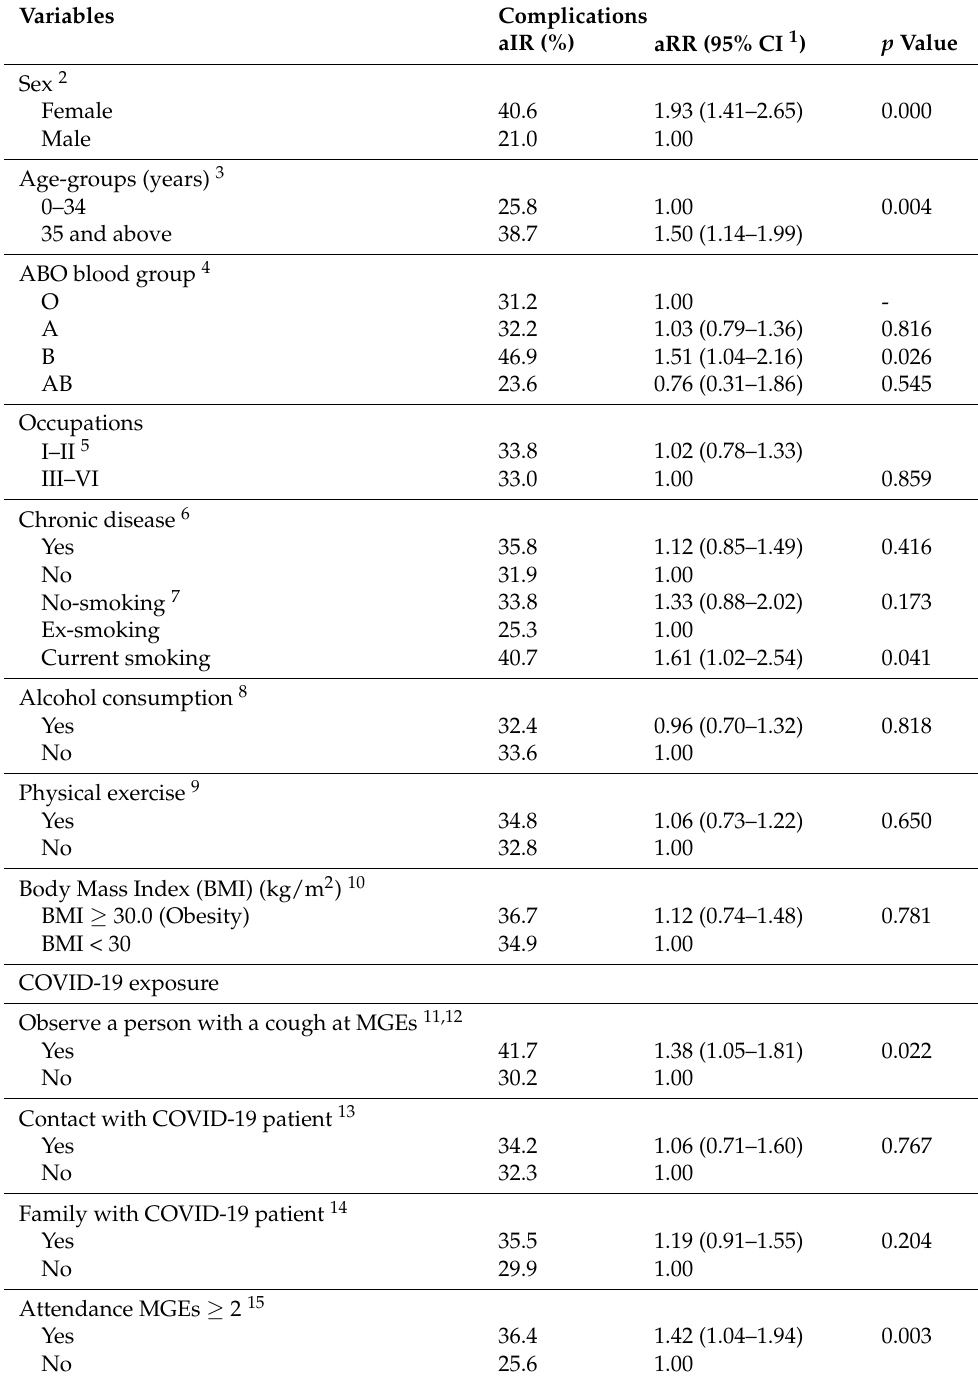
Table 6. Complications, risk factors, adjusted incidence ratio (aIR) and adjusted relative risk (aRR). Borriana COVID-19 cohort 2020.